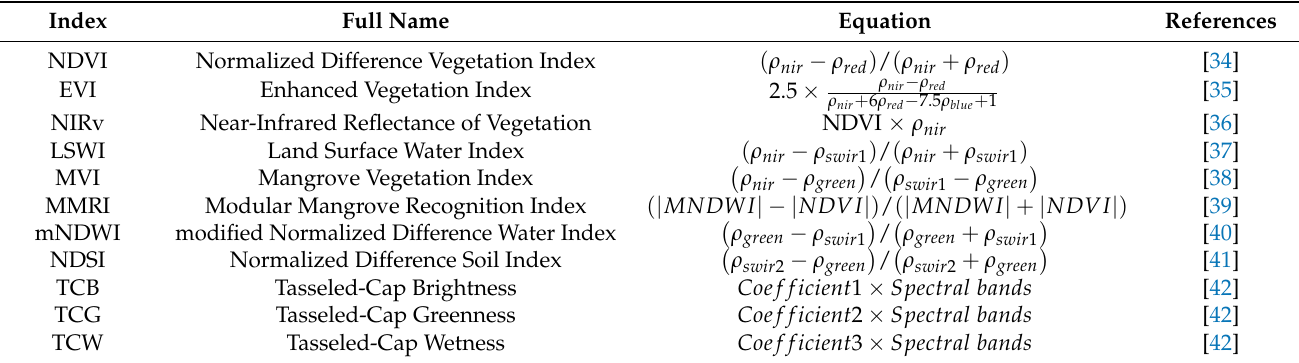
Table 1. Spectral indices used in the